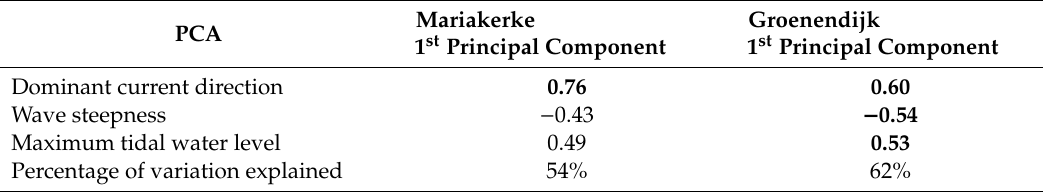
Table 4. Correlations between daily dominant current direction, daily averaged wave steepness, maximum tidal water level, and the first principal component for both study sites combined. High correlations are bold ( >